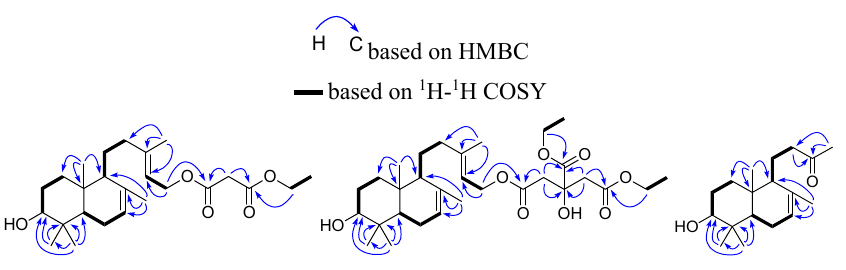
Figure 2. Key 1 H- 1 H COSY, HMBC correlations of compounds 1 – 3 .